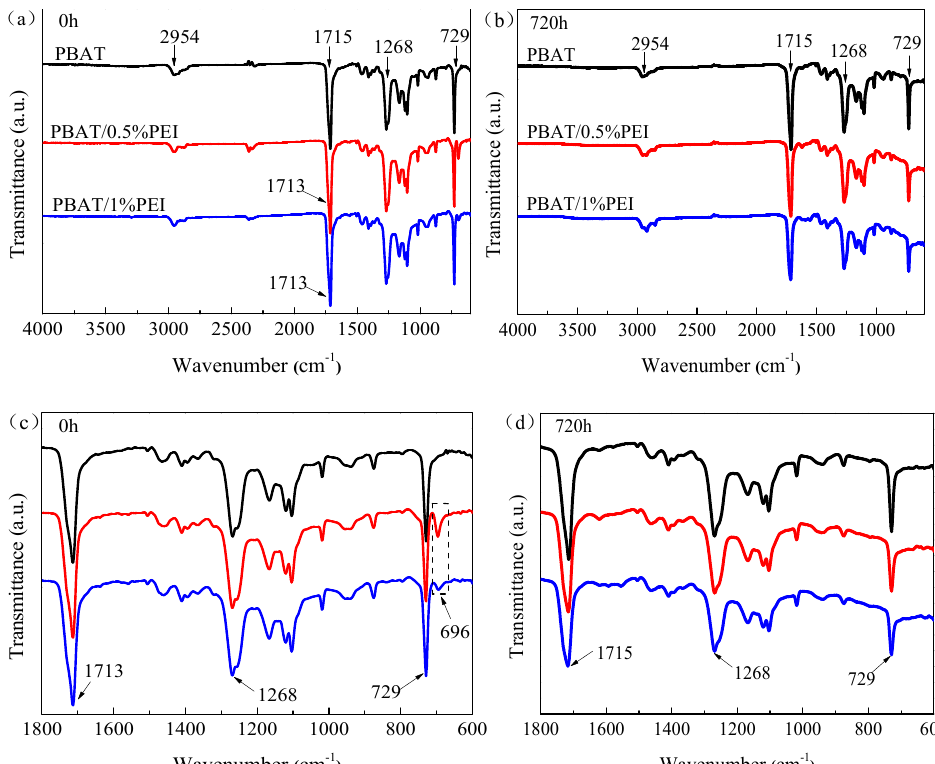
Figure 5. FTIR spectra for PBAT and PBAT/PEI films (( a ) a full FTIR spectra before degradation; ( b ) a full FTIR spectra after 720 h photodegradation; ( c ) zoom of the region 1500–600 cm − 1 before degradation; ( d ) zoom of the region 1500–600 cm − 1 after 720 h photodegradation).